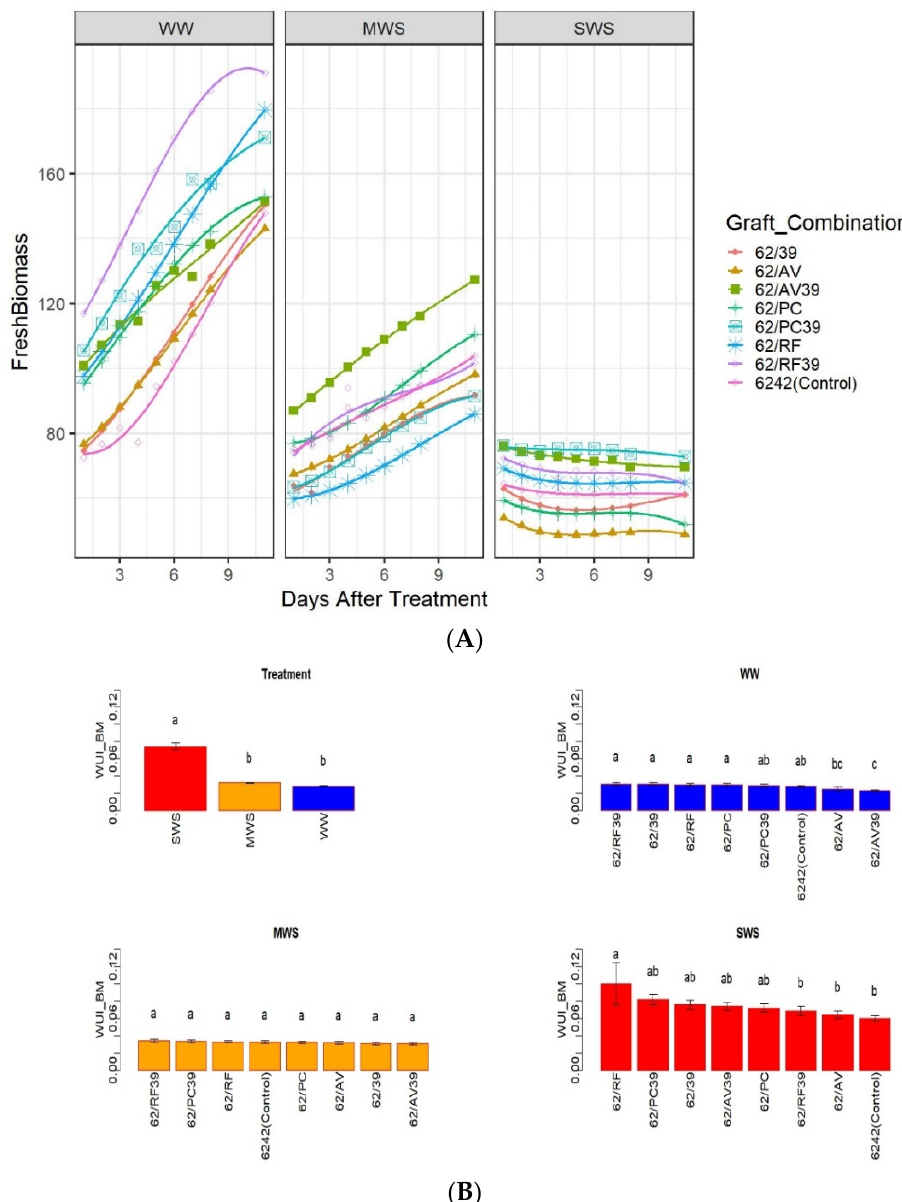
Figure 2. Effects of water stress and graft combinations on fresh biomass and WUI_BM. ( A ) Variations in fresh biomass in response to water stress levels represented by an average of four replications in well-watered (WW), moderately water stressed (MWS) and severely water stressed (SWS) plants. ( B ) Each bar in each figure represents the mean values of four replications for WUI_BM in the graft combinations. Letters represent the significance of differences among mean values, as computed by the DMRT at 0.95 CI. Graft combinations with common letters are not significantly different from each